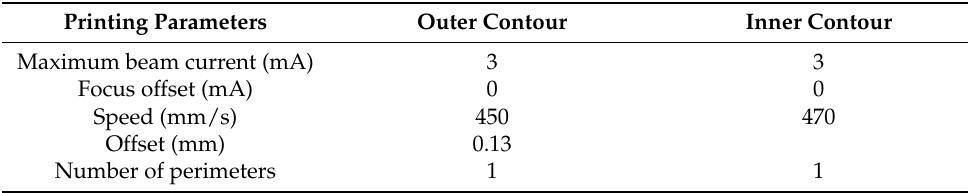
Table 3. Arcam A2X printing parameters.